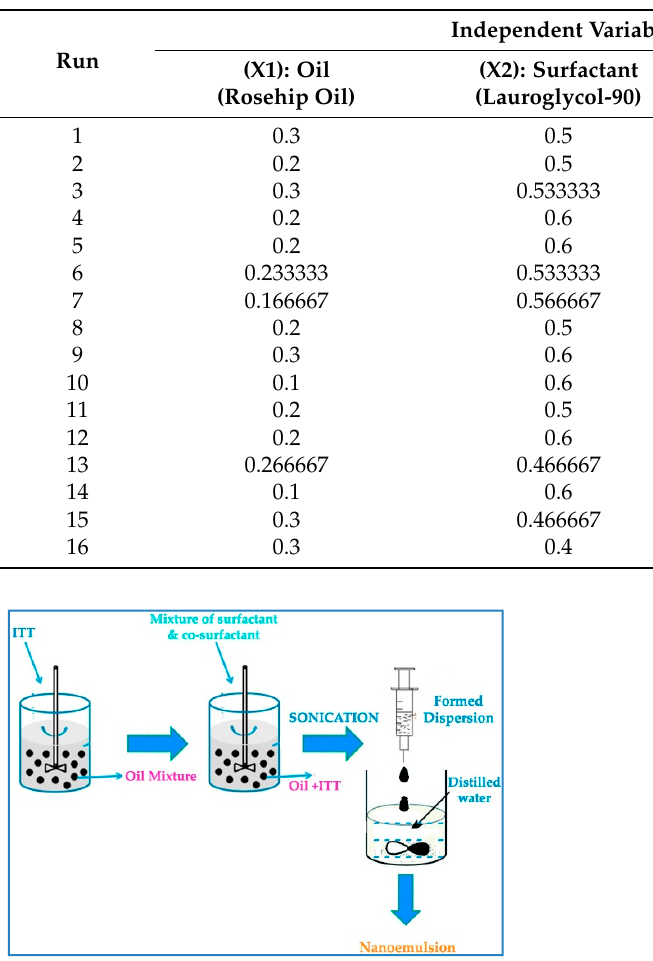
5 of 16 Table 3. Mixture design for the development of ITT-QRS-loaded self-nanoemulsifying drug